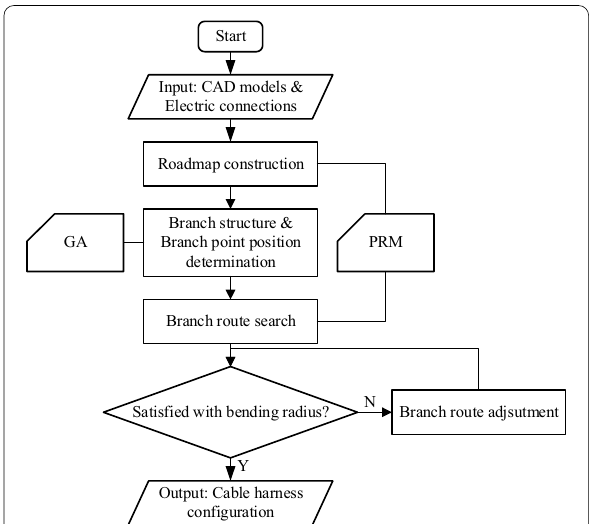
Figure 3 The framework of the algorithm used in this paper